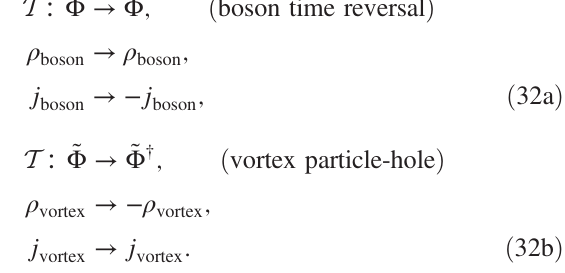
FIG. 6. Bosons e i φ reside on the direct lattice labeled by integers. Vortices e i ~ φ live on the dual lattice labeled by half- integers. Vortex hopping across wire y is implemented by a phase slip e − 2 i θ y on that wire. Creating an isolated vortex requires a string of such operators emanating from infinity. Here, we define the vortex creation operator by running “ half ” of the string from −∞ and the other half from þ ∞